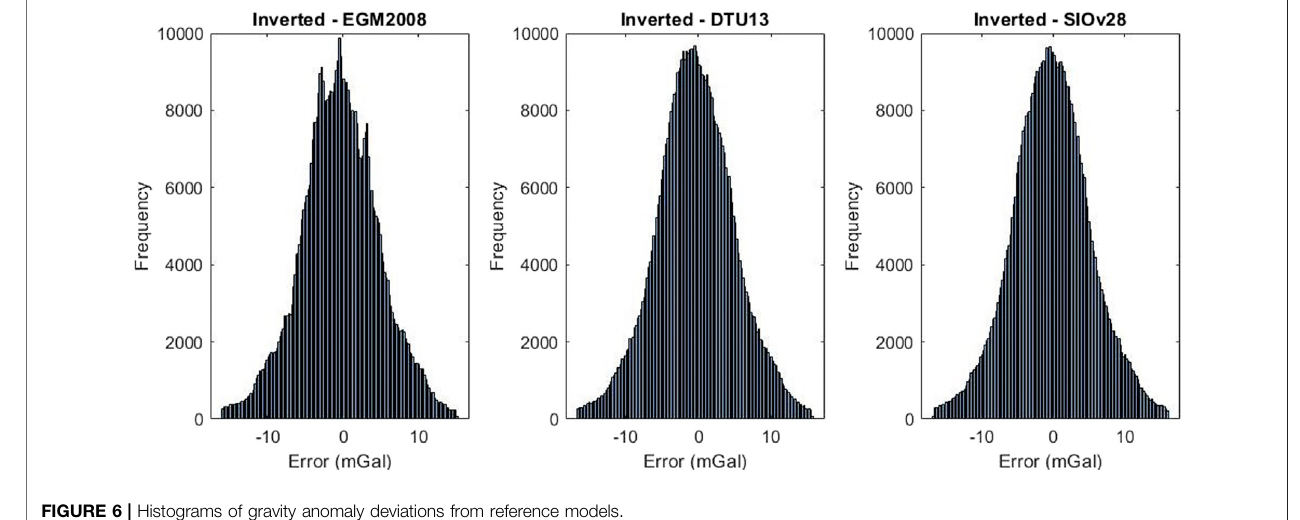
FIGURE 6 | Histograms of gravity anomaly deviations from reference models.